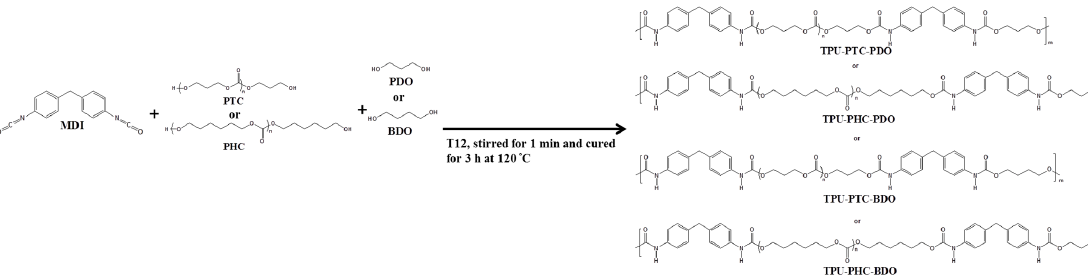
Figure 2. Synthesis route of TPU copolymers.